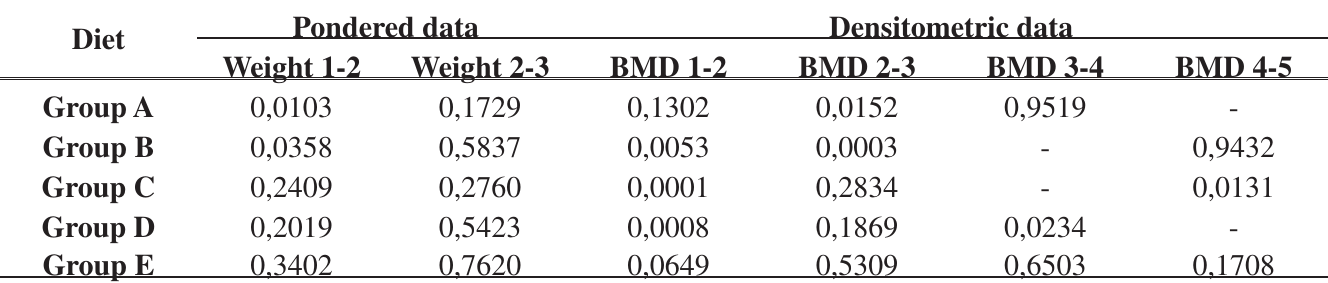
TABLE 1 – Value of p of the variance analysis for measures repeated to evaluate the effect of intervention (experimental groups x control) in the weight of rats and in the mass’ bone